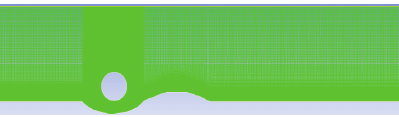
Figure 2: The grid for the model calculation.